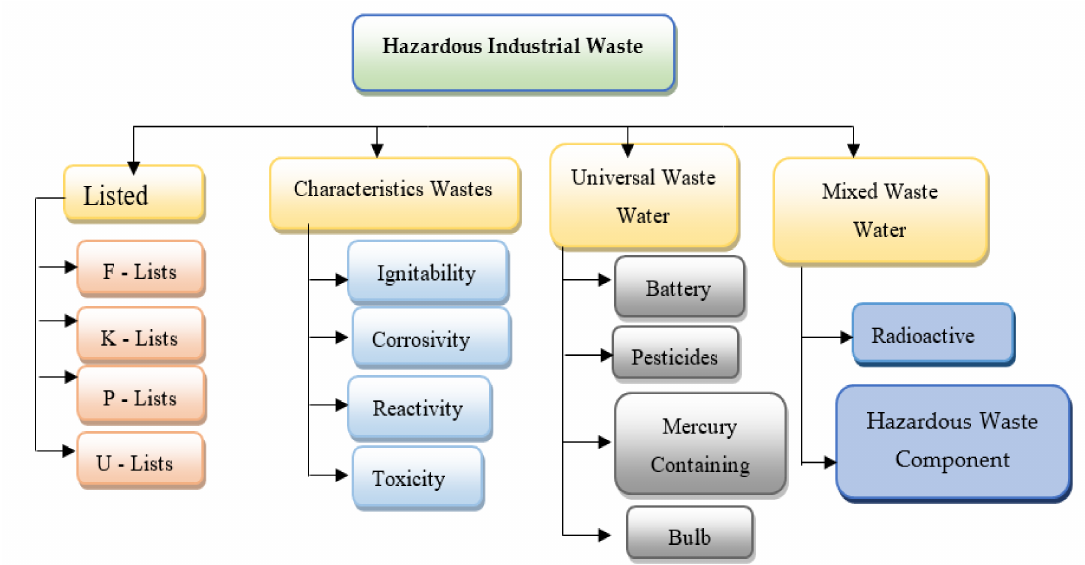
Figure 2. Industrial hazardous wastes general classification (reprinted with permission from [8]). F-list (wastes from common manufacturing and industrial processes), K-list (wastes from specific industries), P-list, and U-list (wastes from commercial chemical